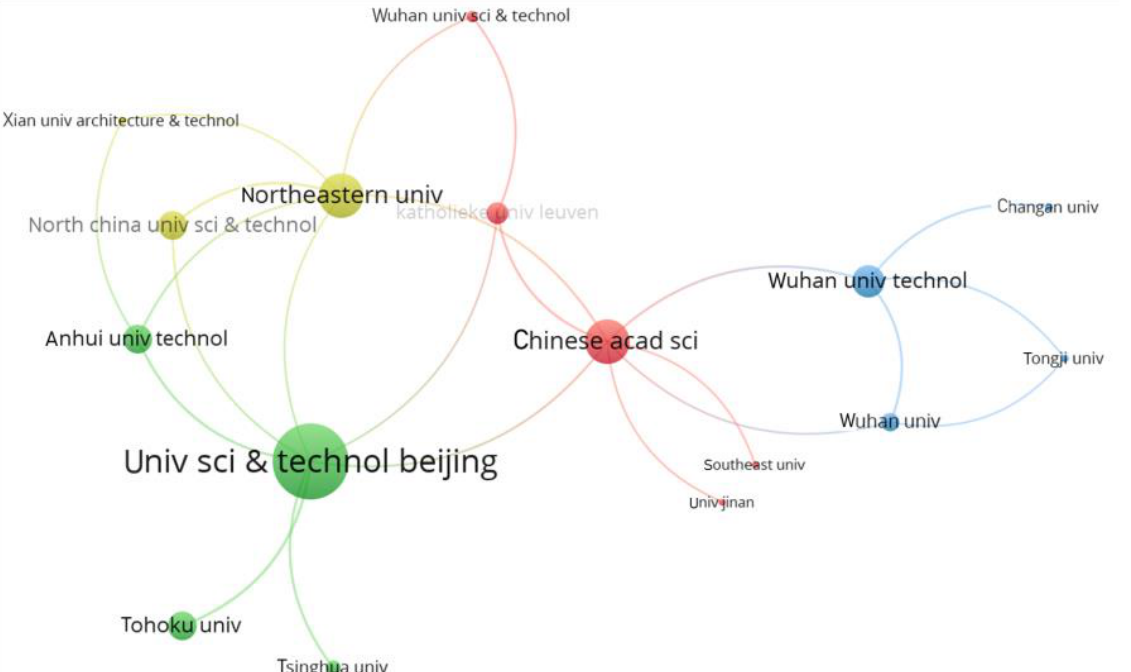
8 of 20 Figure 6. The H-index and CPP of the top 15 productive institutions.